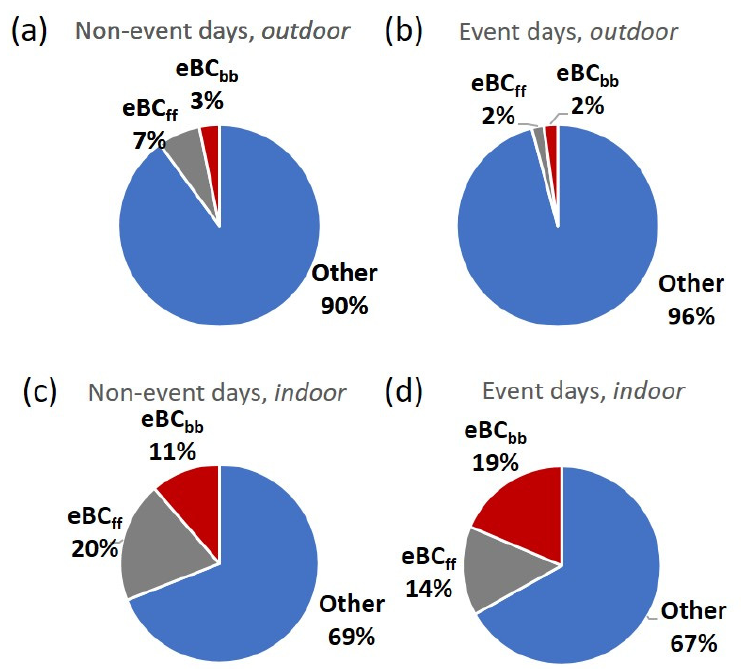
Figure 9. Pie charts of PM 2.5 chemical composition during non-event days in outdoor ( a ) and indoor ( c ) air and during event days in outdoor ( b ) and indoor ( d ) air.